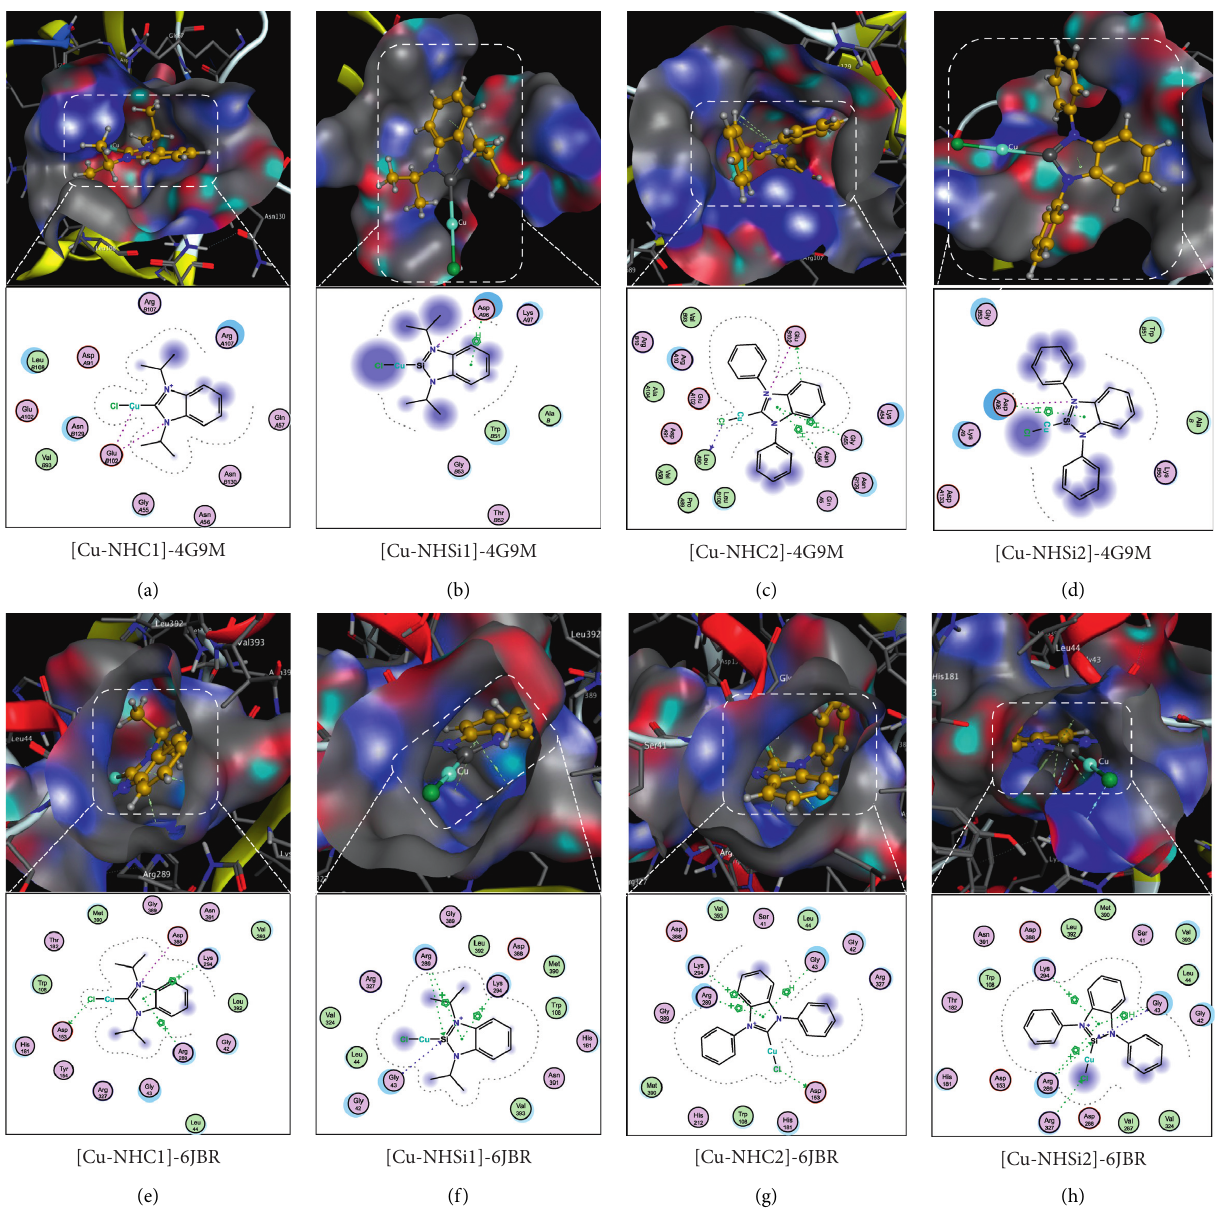
Figure 8: Visual presentation and in-pose interaction map of ligand-4G9M and ligand-6JBR: (a) [Cu-NHC1]-4G9M, (b) [Cu-NHSi1]- 4G9M, (c) [Cu-NHC2]-4G9M, (d) [Cu-NHSi2]-4G9M, (e) [Cu-NHC1]-6JBR, (f) [Cu-NHSi1]-6JBR, (g) [Cu-NHC2]-6JBR, and (h) [Cu-